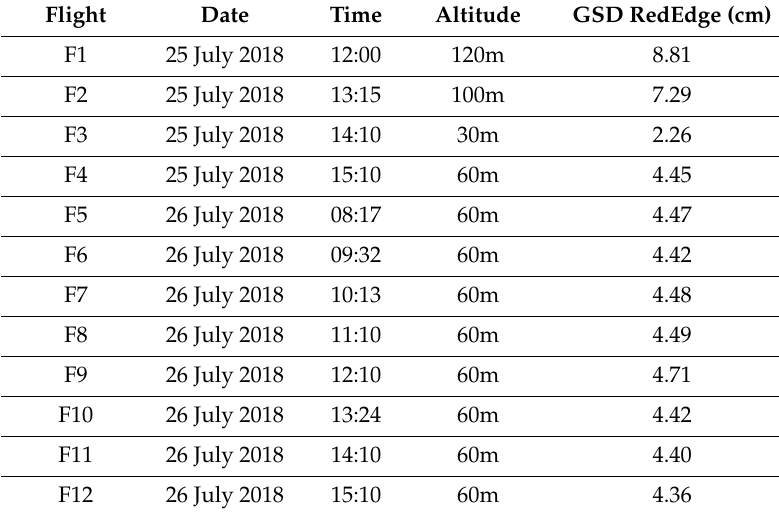
Table 1. Overview of UAV (unmanned aerial vehicles) flights flown on 25 July 2018 and 26 July 2018 with a MicaSense RedEdge multispectral camera at varying times and ground sampling distances